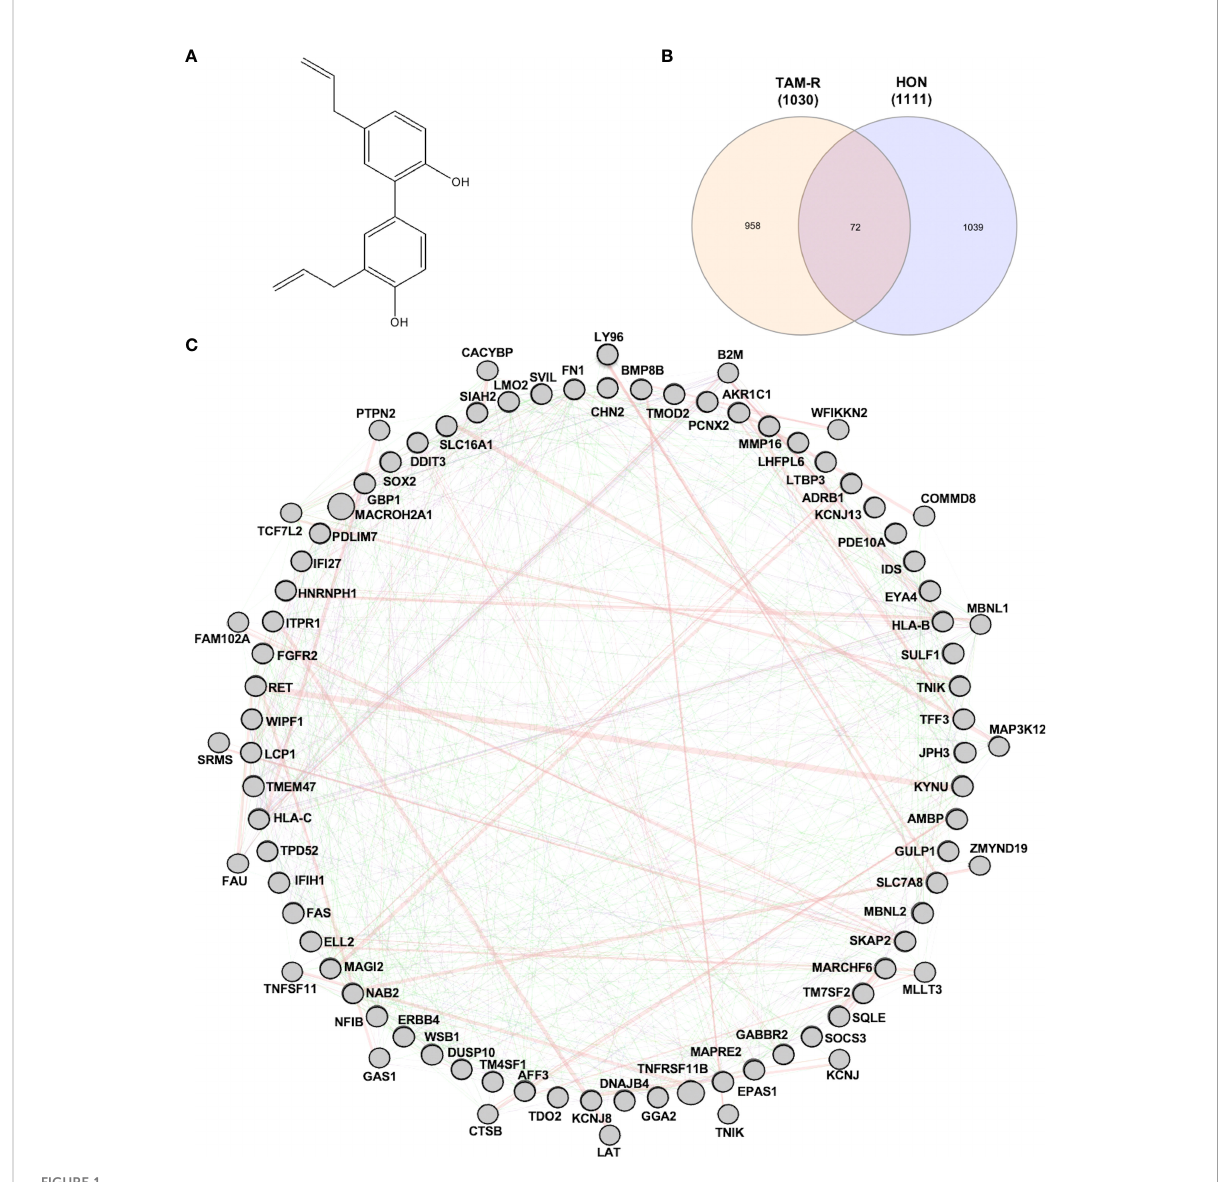
FIGURE 1 (A) Structure of honokiol (HON). (B) Venn diagram of differentially expressed genes (DEGs) from tamoxifen-resistant (TAM-R) and HON-treated MCF-7 cells. (C) Protein-protein interaction network of the protein related to overcoming TAM resistance by HON as analyzed using